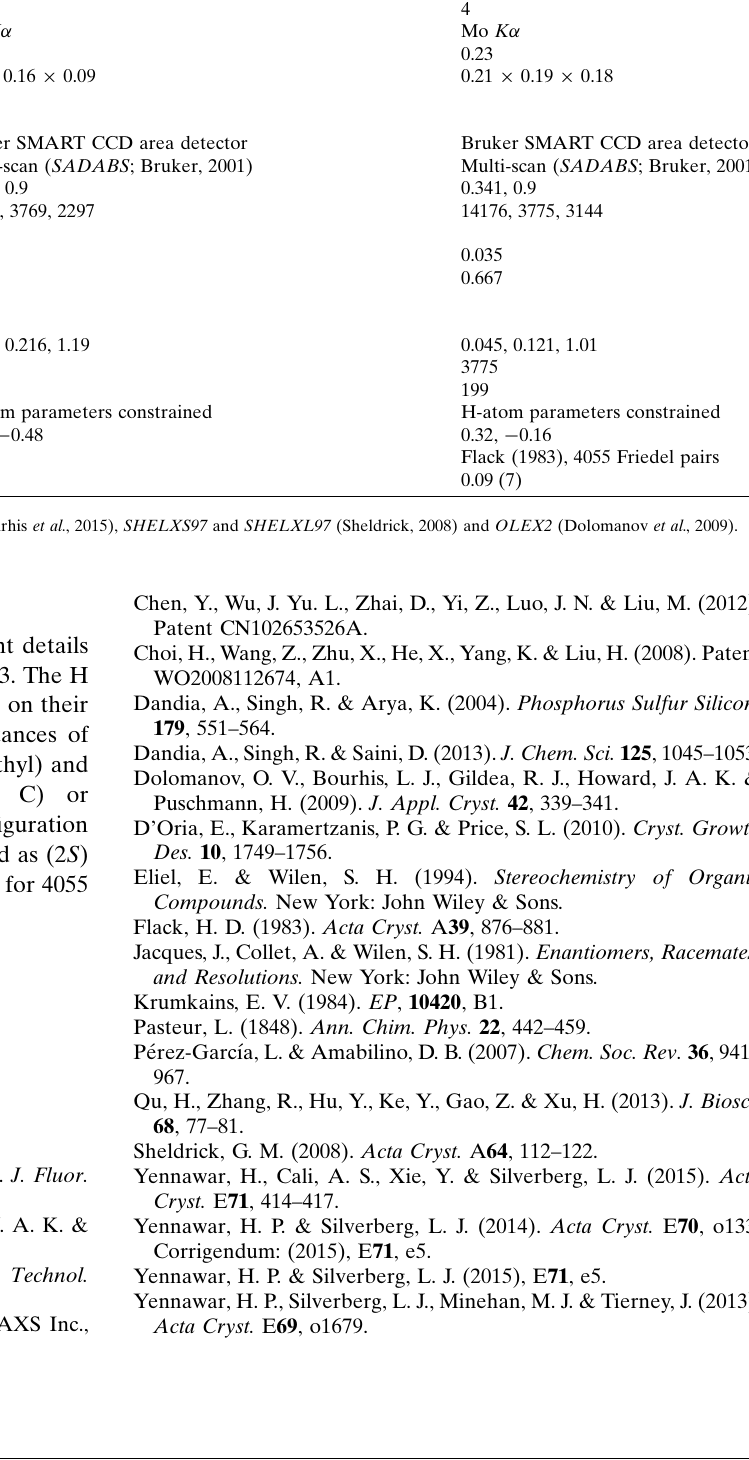
Crystal data Chemical